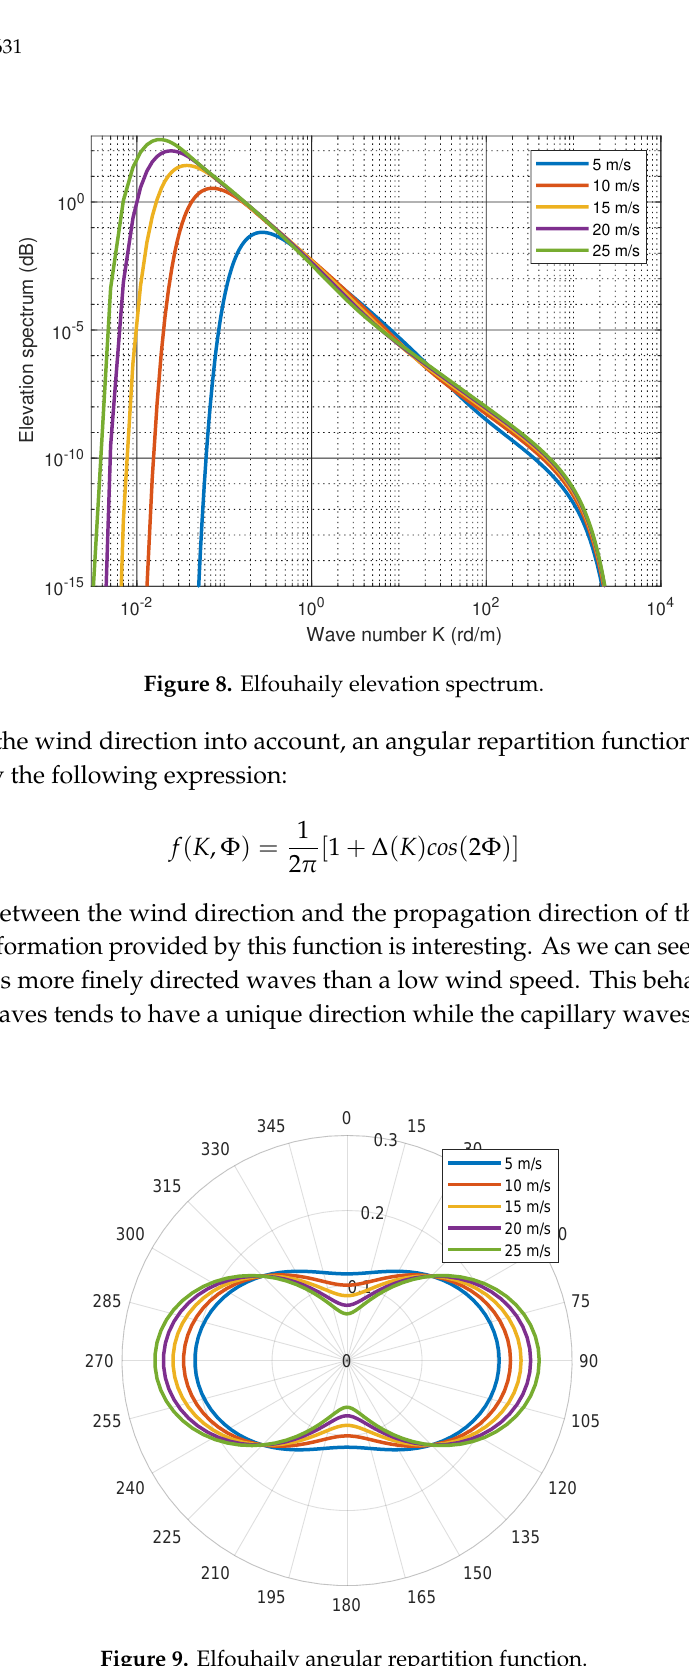
Figure 9. Elfouhaily angular repartition